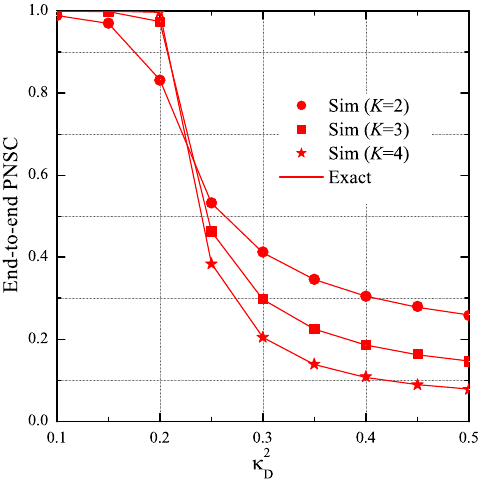
Figure 10. End-to-end probability of non-zero secrecy capacity as a function of κ 2 η = 0.25, x B = 0.5, y B = 0.3, x P = 0.5, y P = − 0.5, x E = 0.5, y E = 0.5, κ 2